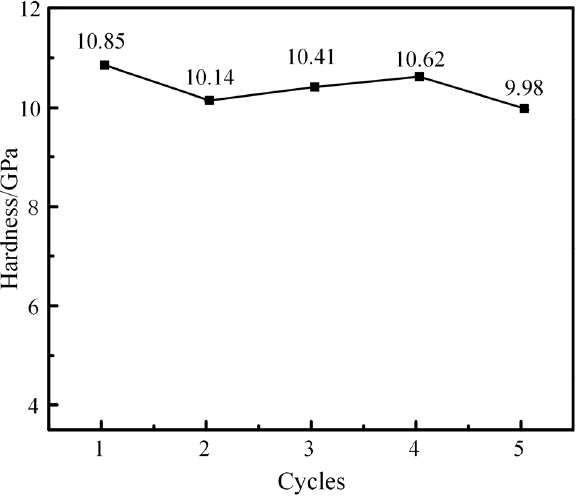
Figure 7. Hardness values of M50 bearing steel in five times nanoindentation test.